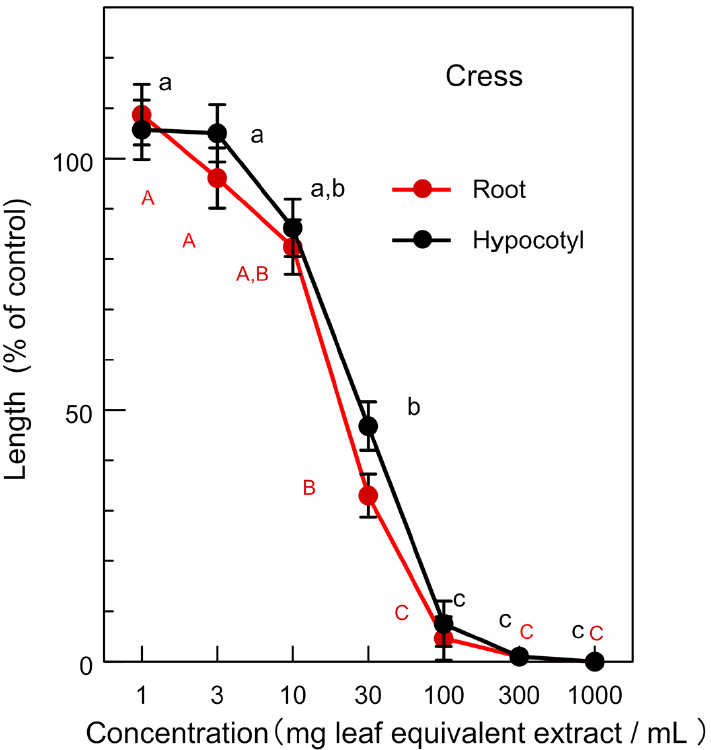
Figure 3. E ff ects of M. glyptostroboides leaf extracts on the growth of roots and hypocotyls of cress. Means ± SE from 3 independent experiments with 10 seedlings for each determination are shown. Other details as for Figure 2.